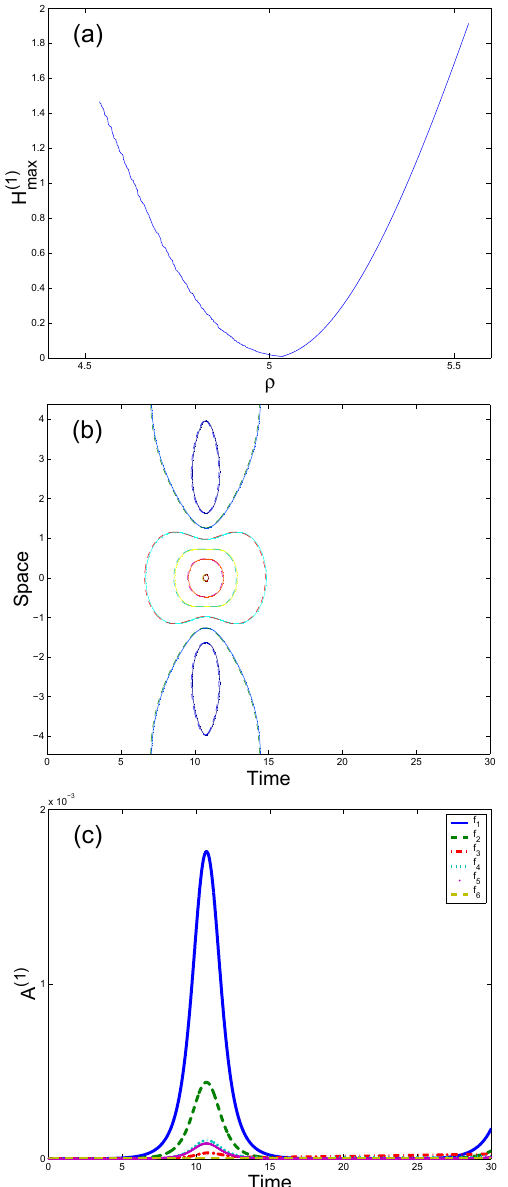
Figure 4. (a) H ( 1 ) max (ρ) . (b) Contours of | U (cid:15) (x,t) | (dashed line) and the one-mode SPB | U ( 1 ) (x,t ; ρ ∗ ) | (solid line) over a plane wave (t) for each f i with one UM. (c) Evolution of A ( 1 ) i